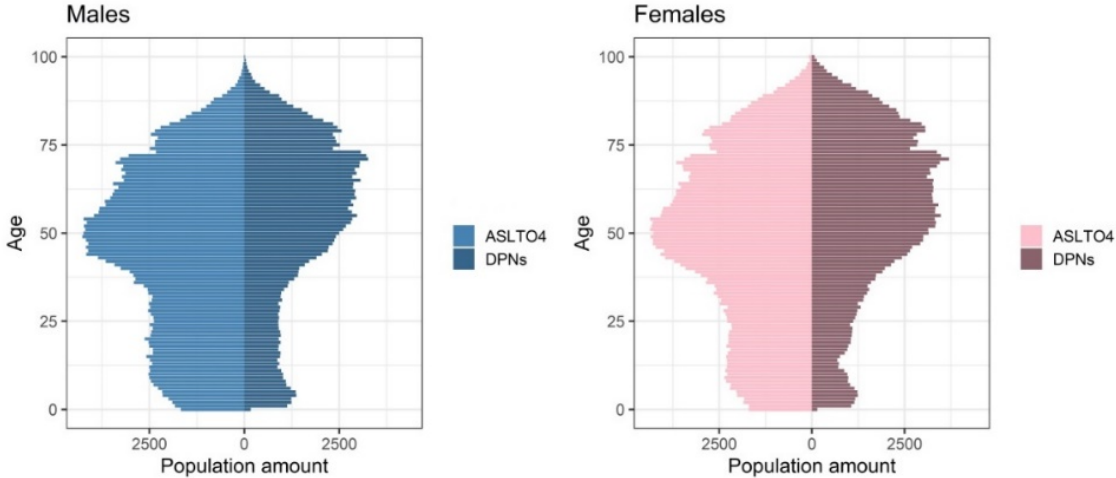
Figure A2. Overall and study population. Age and sex structures of the overall population (ASL TO4) and study population (DPNs) are shown.